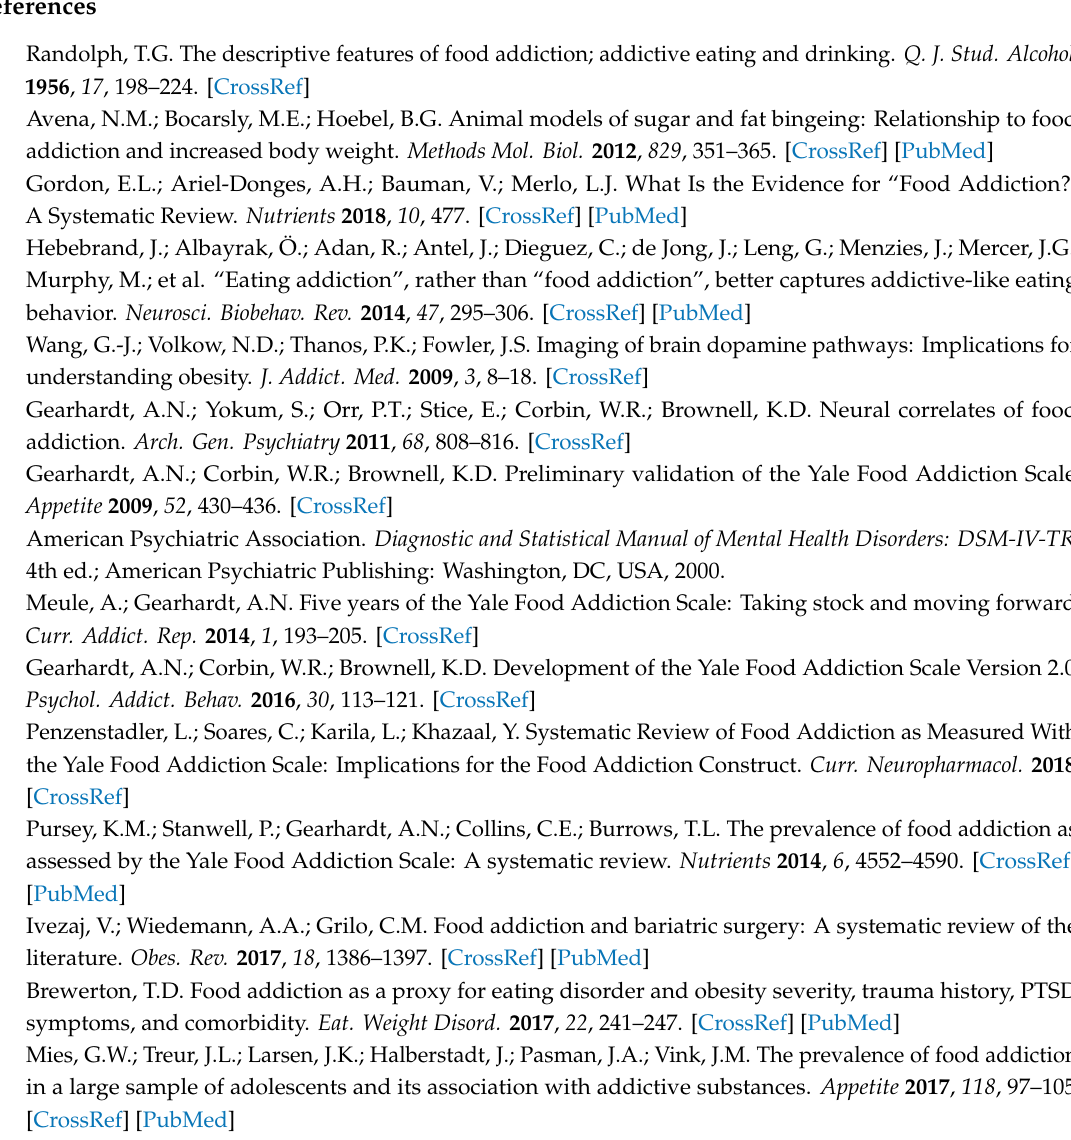
Table S1: Description of the sample according to ED ( n =